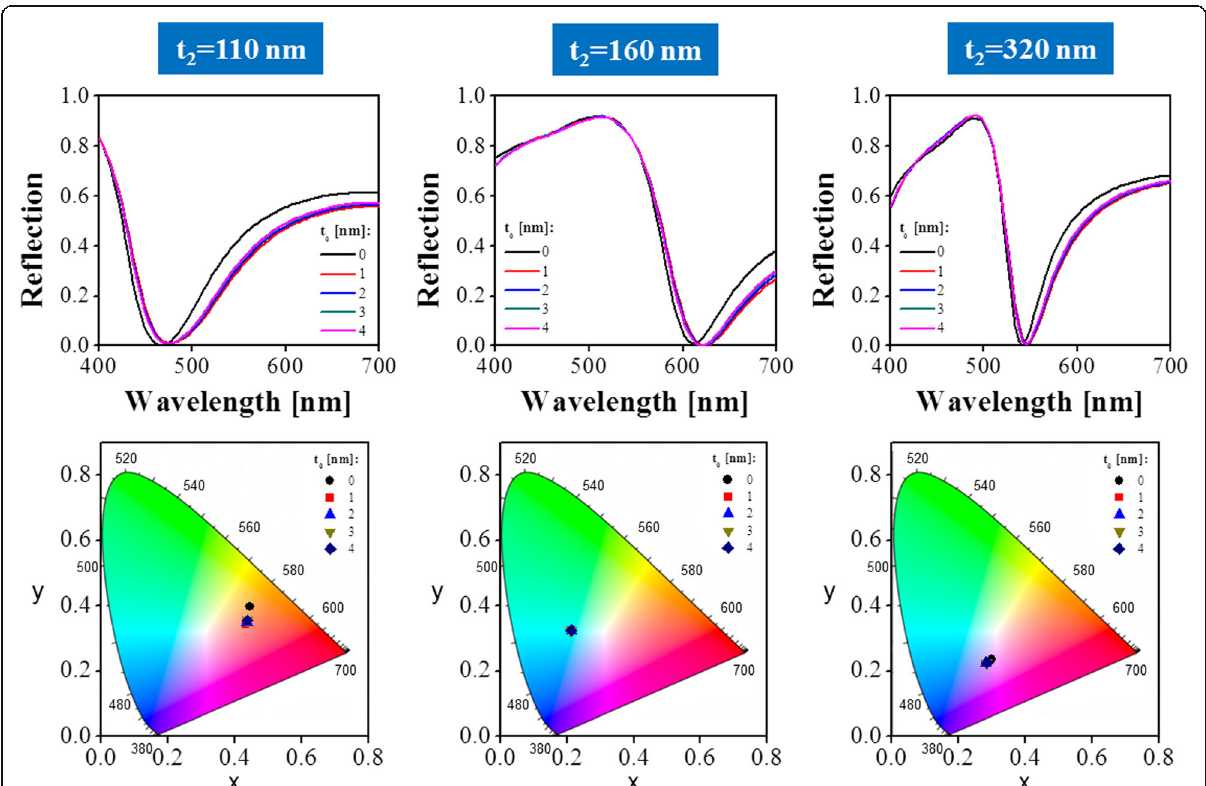
Fig. 7 Simulated reflection spectra of the proposed structure considering the formed alumina layer on top of Al because of the air oxidation of the different NAA cavity thicknesses of 110, 160, and 320 nm